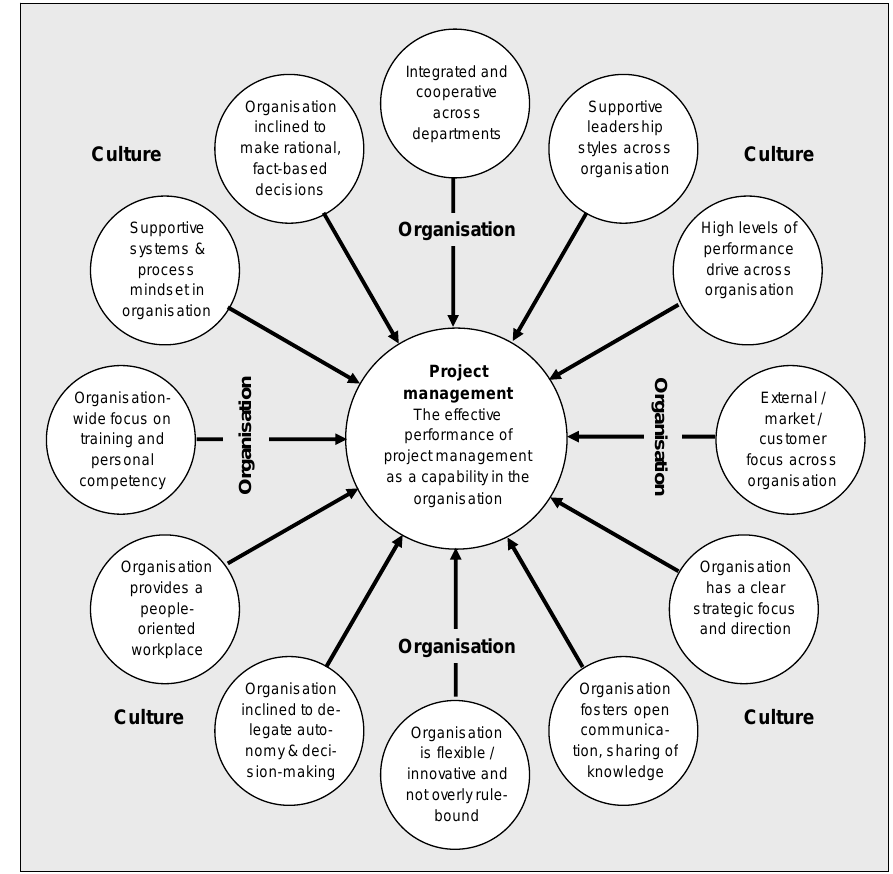
Figure 2: The proposed dimensions of a project management supportive organisational